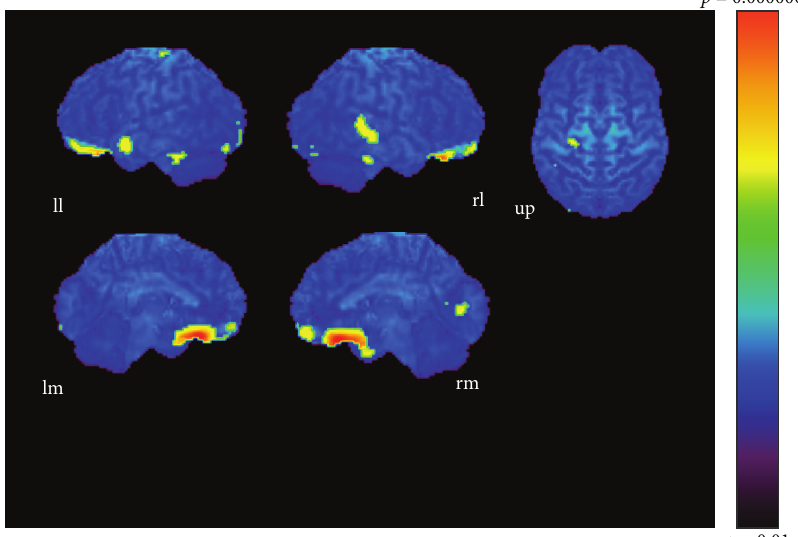
Figure 8: Simple-complex condition ( 𝑝 < 0.001 ). ll: lateral surface of left hemisphere; lm: medial surface of left hemisphere; rl: lateral surface of right hemisphere; rm: medial surface of right hemisphere; up: upper